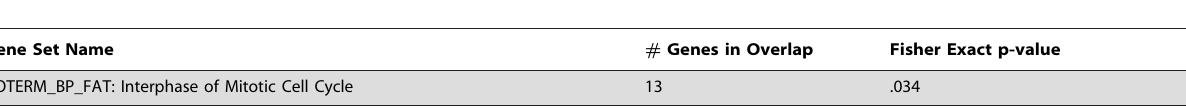
Figure S1 mRNA-seq read distribution for EGFR in the 990141B tumor sample. The distribution and alignment of mRNA-seq data for the 990141B tumor sample (top lane) and SUM102 cell line sample (bottom lane) for the EGFR gene is visualized using IGV. The corresponding tiling array copy number plot for the tumor sample and gene and the associated area of genomic coverage is highlighted in the bottom panel. (PDF) Figure S2 mRNA-seq read distribution for BCL11A in the UNC040182B tumor sample. The distribution and alignment of mRNA-seq data for the UNC040182B tumor sample (top lane) and SUM102 cell line sample (bottom lane) for the BCL11A gene is visualized using IGV. The corresponding tiling array copy number plot for the tumor sample and gene and the associated area of genomic coverage is highlighted in the bottom panel.